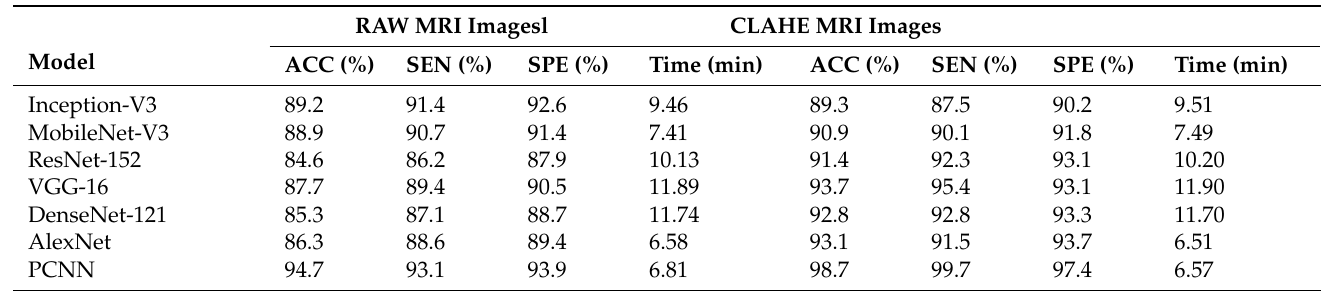
Table 6. Results obtained using different pre-trained models in comparison with the proposed PCNN on the same